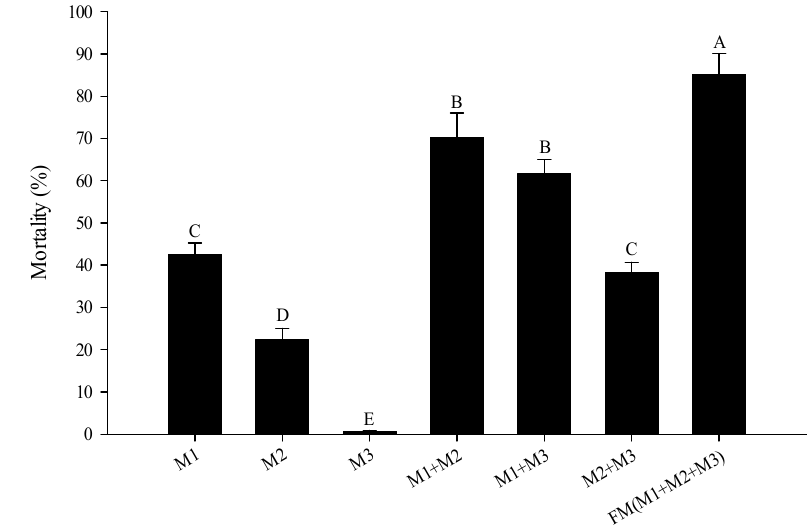
Figure 2. Mortality caused by selected blends of active and inactive constituents of thyme oil when applied at the concentration at which the natural thyme oil causes 95% mortality. M1 (the most active constituent) = thymol; M2 (moderately active constituents) = linalool, terpinene, p -cymene and carvacrol; M3 (inactive constituents) = α -pinene, benzoic acid and ethyl gallate. Error bars represent the standard error of the mean of four replicates (40 mites per replicate). Means followed by different letters are significantly different from each other (Tukey’s test, p < 0.05).